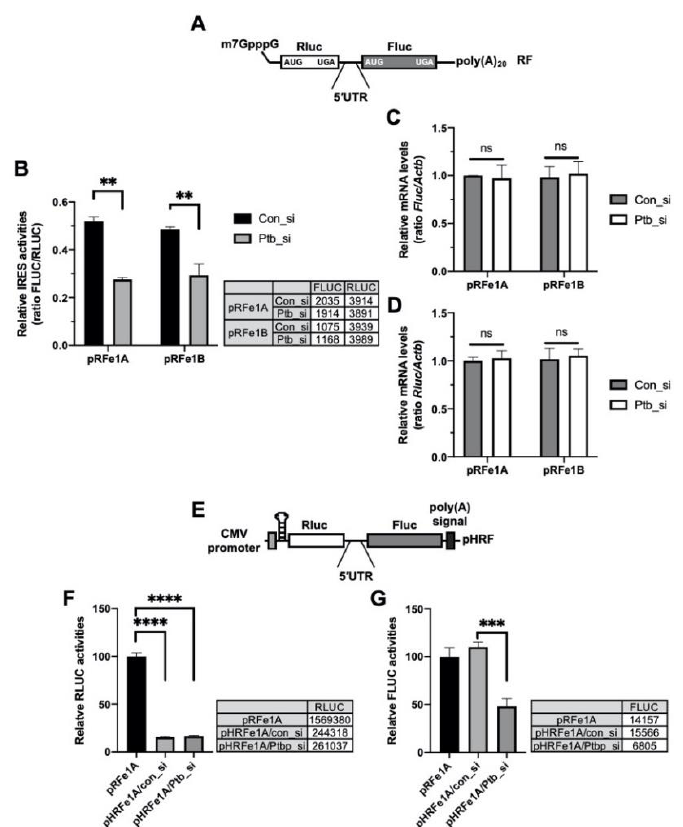
Figure 3. Polypyrimidine tract-binding protein 1 (PTBP1) functions as an IRES-transacting factor (ITAF) of the Per1 mRNA. ( A ) Schematic diagram of the bicistronic mRNA reporter containing the Per1 5 (cid:48) -untranslated regions (UTRs). ( B ) con_si or Ptb_si was transfected into NIH 3T3 cells and incubated for 12 h. Subsequently, the cells were transfected with the Per1 mRNA reporters. After incubation for 6 h, the cells were used for the luciferase assay. n = 3; ** p < 0.01, as determined by two-way ANOVA with Sidak’s multiple comparison test. ( C , D ) Relative mRNA levels in the same sample mentioned for panel B were checked by real-time PCR with the indicated specific primers. n = 3; two-way ANOVA with Sidak’s multiple comparison test was performed. ( E ) The bicistronic vector harboring a hairpin and loop with the Per1 5 (cid:48) -UTRs. ( F , G ) The hairpin-inserted reporter constructs were transfected into NIH 3T3 cells and these cells were used for luciferase assay. The luciferase activities of the pRF vector containing the Per1 5 (cid:48) -UTR e1A (RLUC, panel F; FLUC, panel G) was set to 100. n = 3; **** p < 0.0001, *** p < 0.001, as assessed by one-way ANOVA with Tukey’s multiple comparison